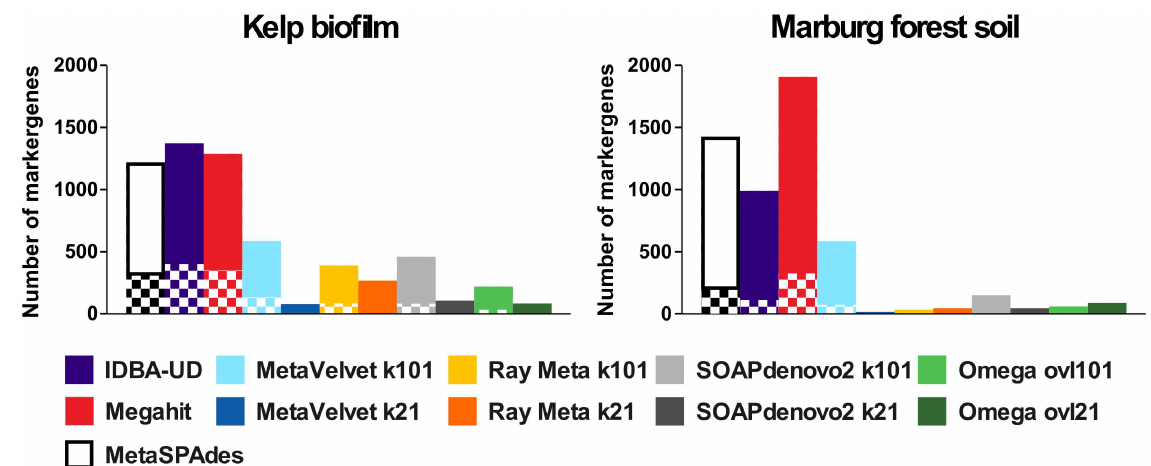
Fig 5. Overall markergene abundance and redundancy for metagenomes from Kelp biofilm (KBF) and Marburg forest soil (MFS) samples. Bar heights indicatethe total abundance of universalbacterialmarker gene products > 100 amino acids, predicted on scaffolds > 500 bp for each assembly, using fetchMG (www.bork.embl.de/software/mOTU/fetchMG.html) [74]. As this value is derived from multiple marker gene types, which co-occur within the same genome, this value does not directly represent the actual number of species captured by the assemblies,rather indicating the overall capturedmetagenomic potential in terms of species genomecompleteness as well as diversity. Checkeredsegmentsof each bar indicateuniquemarker geneproducts, while the solid segmentsindicate the fraction of closely related and redundantprotein sequences, sharing more than 90% amino acid identity. The latter indicatethe potentialmicro diversity captured by each assembler.For a detailed breakupof individual marker gene abundances and diversities pleaserefer to S3